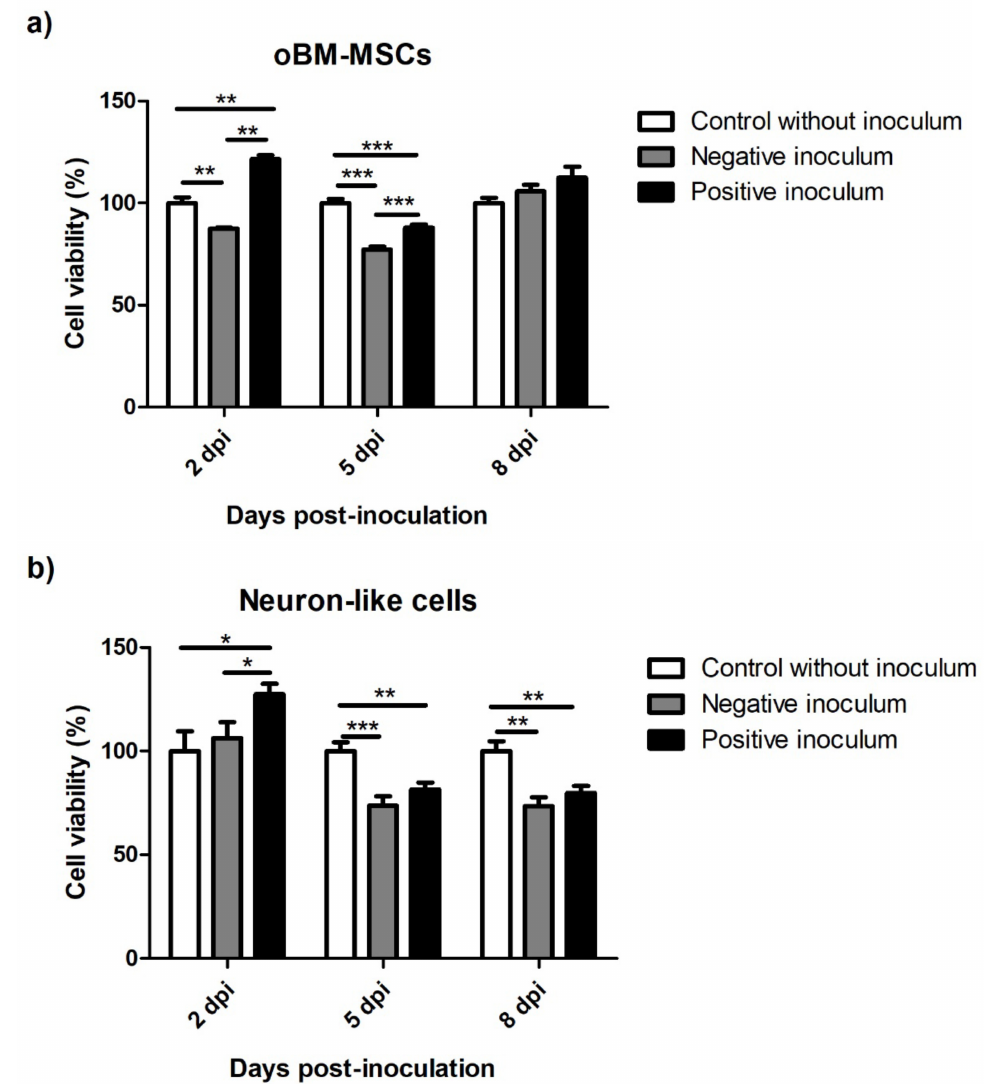
Figure 9. Cell viability of oBM-MSCs ( a ) and neuron-like cells ( b ) 2, 5, and 8 days after prion infection. The viability values are presented as percentages (%), considering the viability of the controls without inoculum as 100% for each infection time. Data are shown as mean values ± SEM. * p < 0.05; ** p < 0.01; *** p <